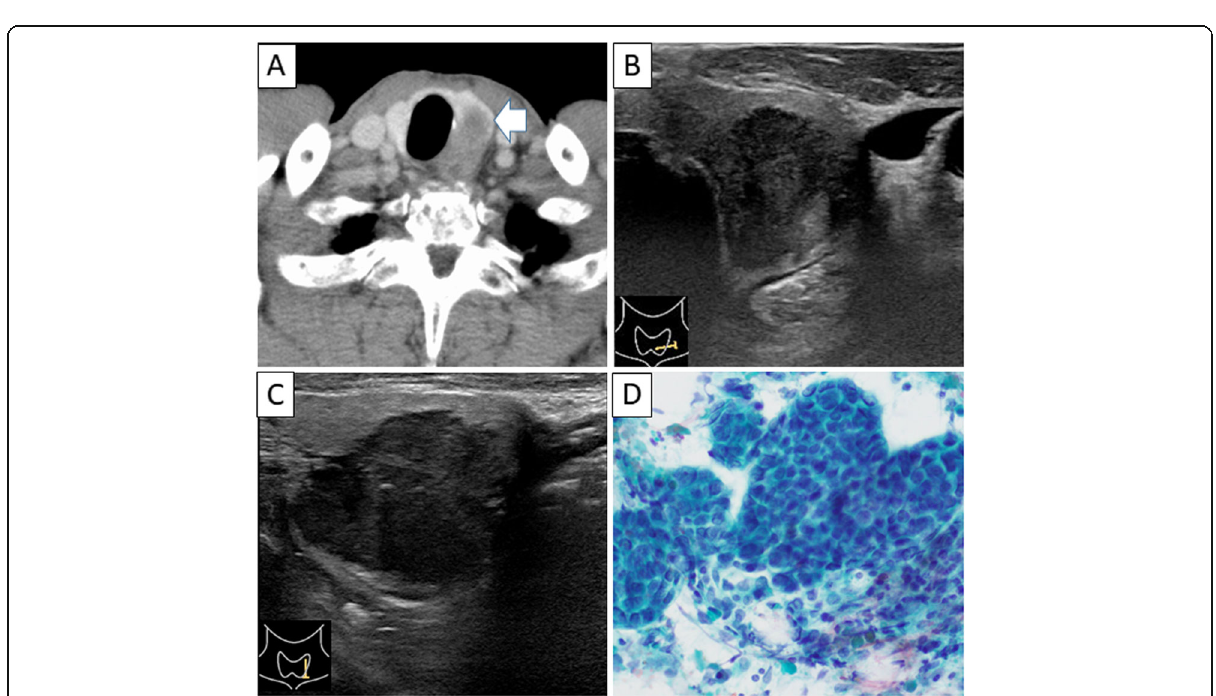
Fig. 2 Imaging and pathological findings. a Contrast-enhanced computed tomography (CT) revealed a low-density mass in left thyroid gland. b , c Ultrasonographic (US) examination showed a hypoechoic, indistinct border and heterogeneous nodule measuring 16.9 mm × 19.7 mm × 23.9 mm in the left lobe of the thyroid gland. d Pathological examination of an ultrasound-guided fine-needle aspiration showed